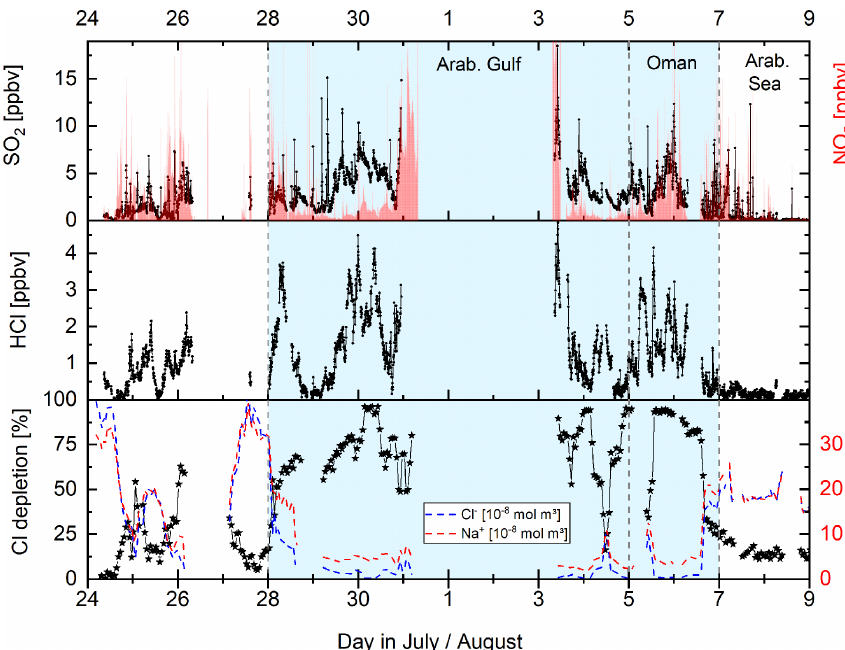
Figure 7. Co-variance between mixing ratios of SO 2 , NO 2 , and HCl and particulate chloride depletion (calculated from Eq. 12) illustrated by the difference in Cl − and Na + (PM 1 ) measured. Chloride depletion of up to 90% indicates effective acid displacement of HCl by HNO 3 and H 2 SO 4 in this